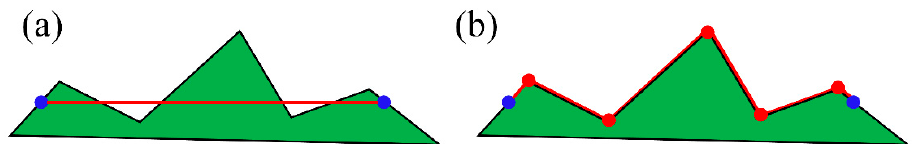
Figure 5. Schematic diagram of reconstruction of fracture ‐ cavity graphics. In ( a ), the red line represents the line segment between any two points on the contour of the fractures or cavities, and the blue point is the two vertices of the line segment. If only the blue vertices of the contour edge are converted to the model surface, the red line segment does not fully fit the model. In ( b ), the red line is reconstructed to generate multiple red points. By connecting all points, the graphics fit perfectly with the model surface.